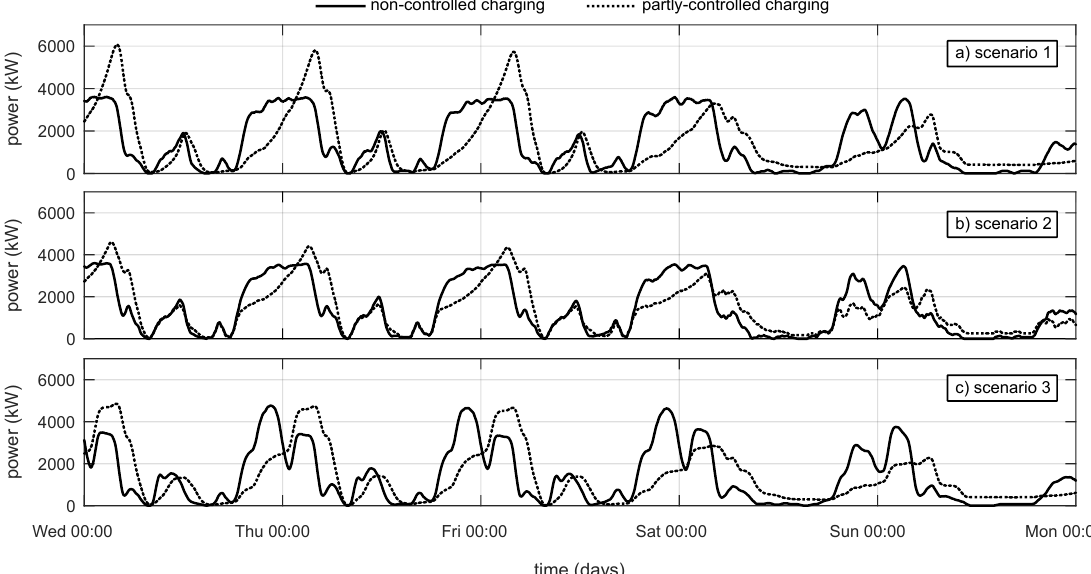
Figure 8. Charging load at the depot obtained by applying non-controlled and partly-controlled